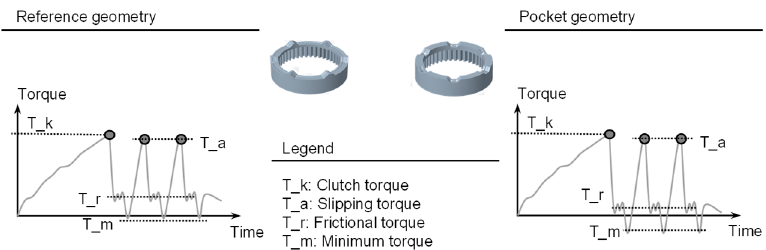
Figure 7. Qualitative torque curve of the overload clutch for two geometry variants. The torque characteristics are plotted to characterize the geometry variants. Adapted representation from Gwosch [26] (p. 148).